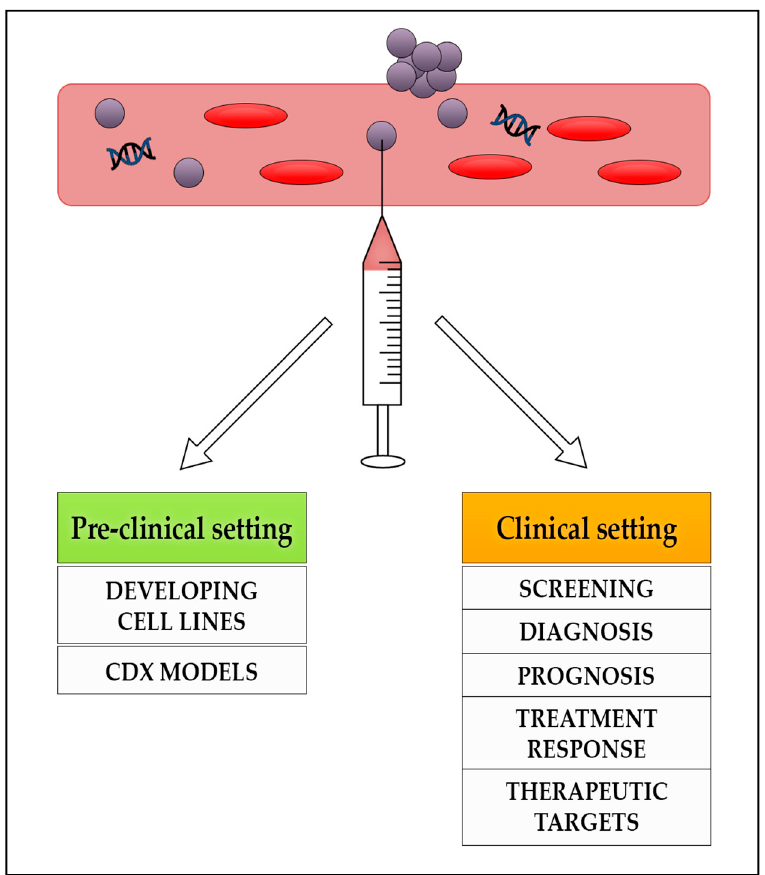
Figure 1. The potential role of liquid biopsies in the management of patients with NENs in the pre-clinical and clinical settings. NENs: neuroendocrine neoplasms; CDX: circulating tumour cells derived